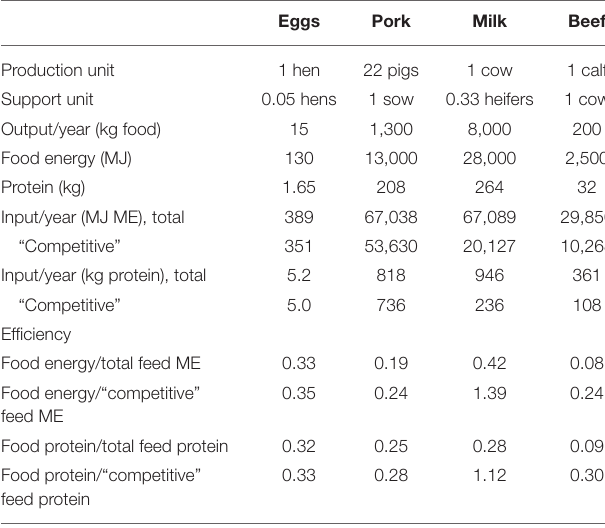
TABLE 2 | Efficiency of energy and protein conversion in meat, milk, and egg production (from Webster, 2013). Eggs